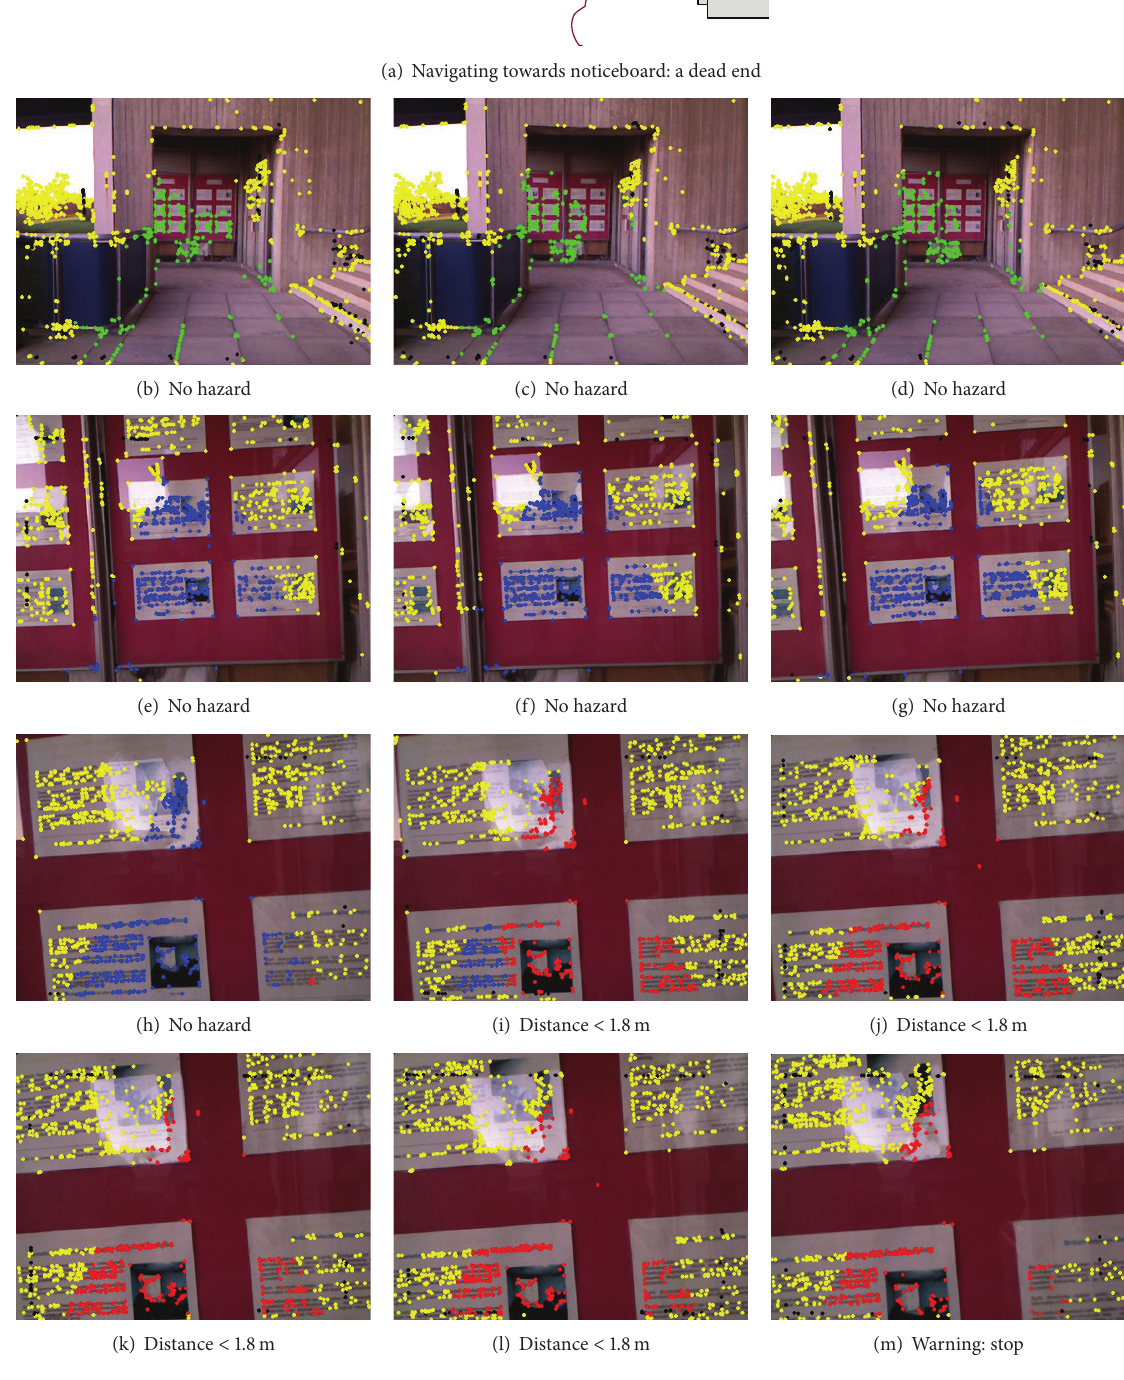
Figure 14: The navigation system’s visual output on an outdoor video sequence, walking towards a wall with noticeboard. (a) presents the complete navigation of the subject (blind person). Images in (b–m) show system’s processing. The system finds red points in frame (i) and so starts counting and generates verbal warning to stop on frame